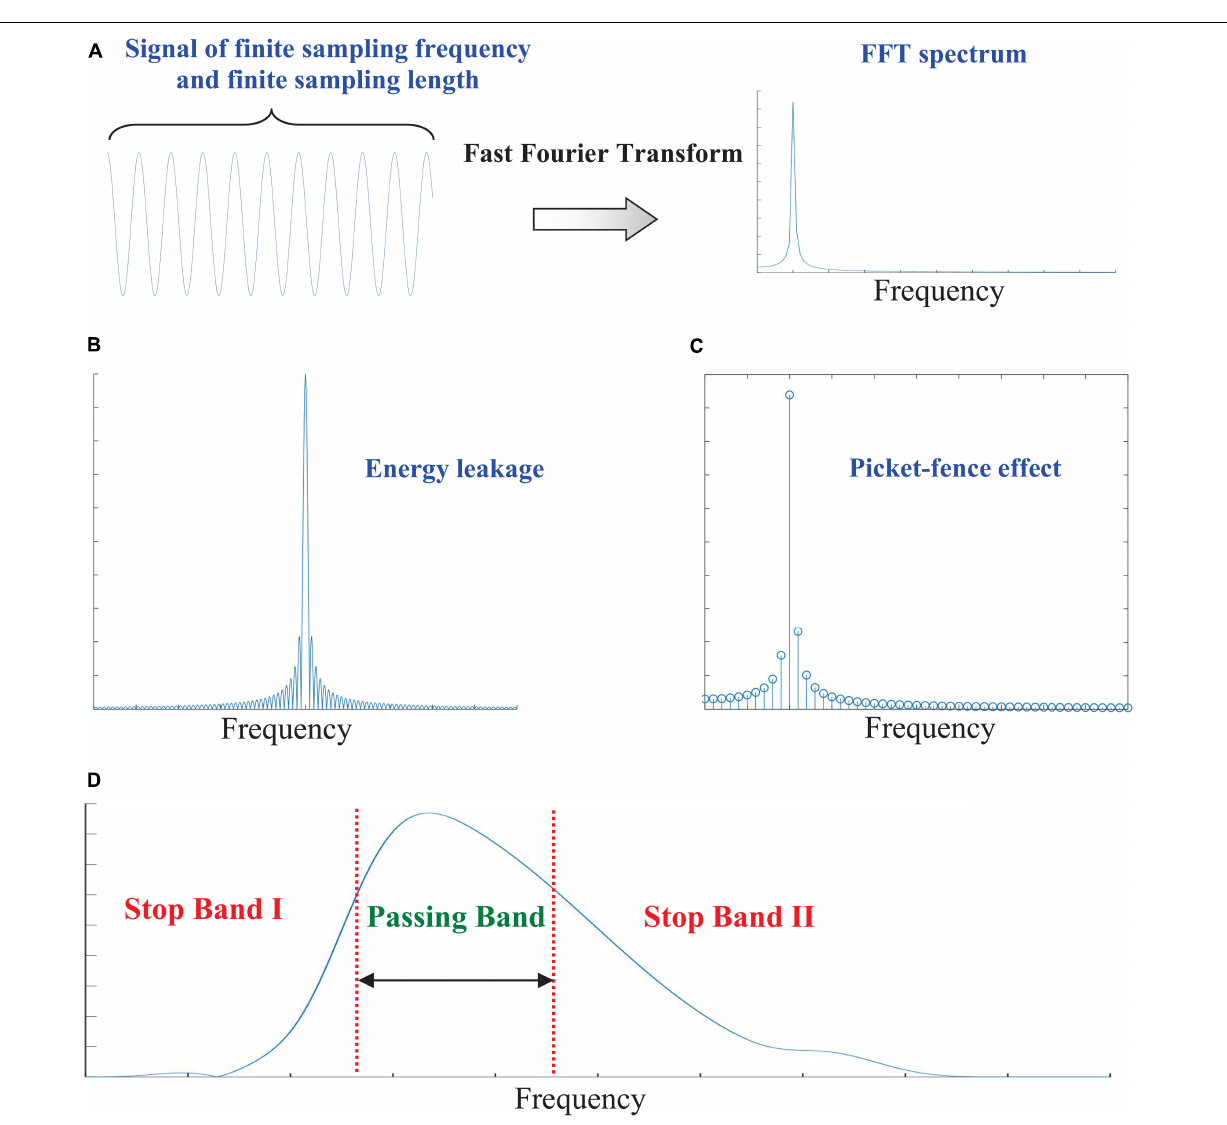
FIGURE 1 | (A) Digitization of dynamic processes with finite sampling frequency and a finite sampling number; (B) FFT spectrum of a sinusoidal component; (C) the energy leakage problem; (D) the picket-fence effect (PFE) and the filtering characteristics of a digital filters from Daubechies wavelet basis (Mallat, 1989; Chen et al.,